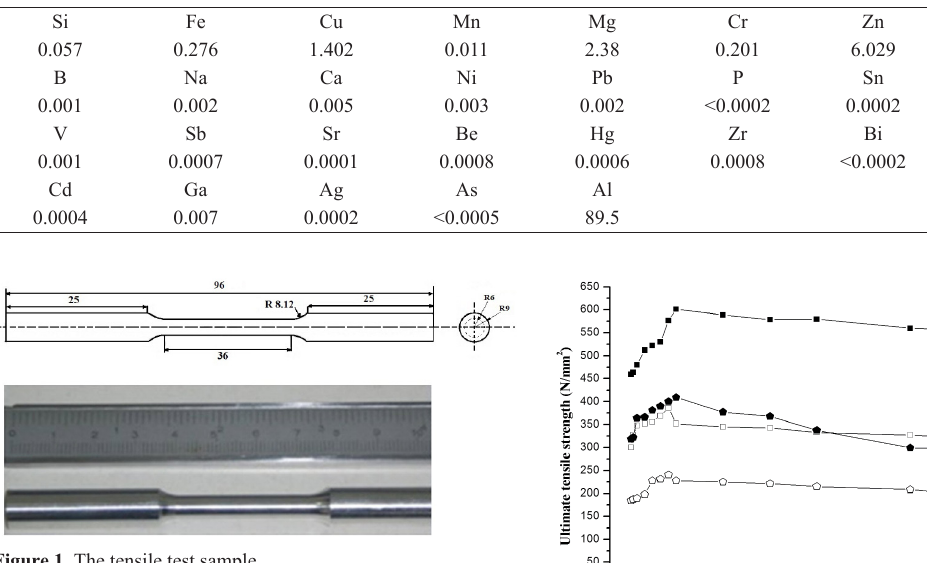
Table 1. The chemical composition of 7075 Aluminum alloys (% weight).